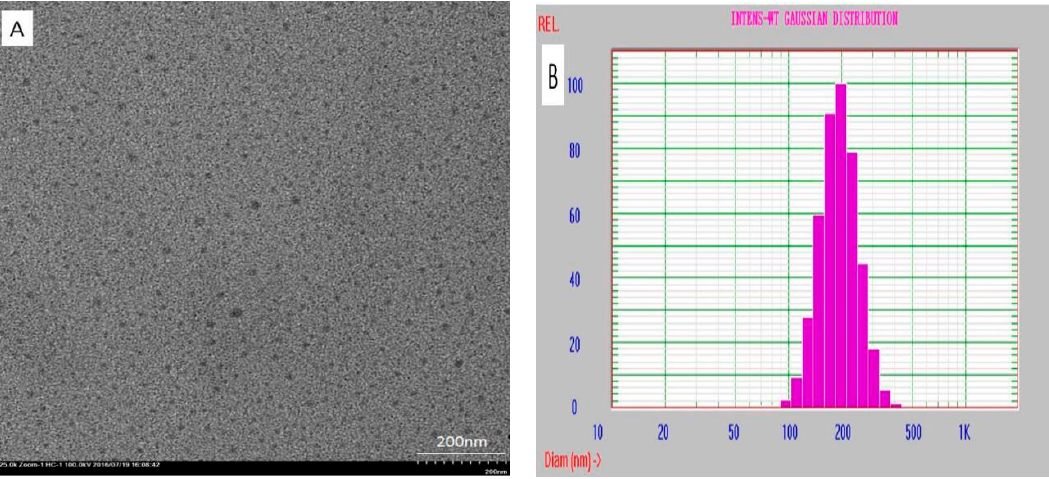
Figure 2. ( A ) TEM image of the dried dPNP and ( B ) the particle size distribution of the hydrated dPNP.